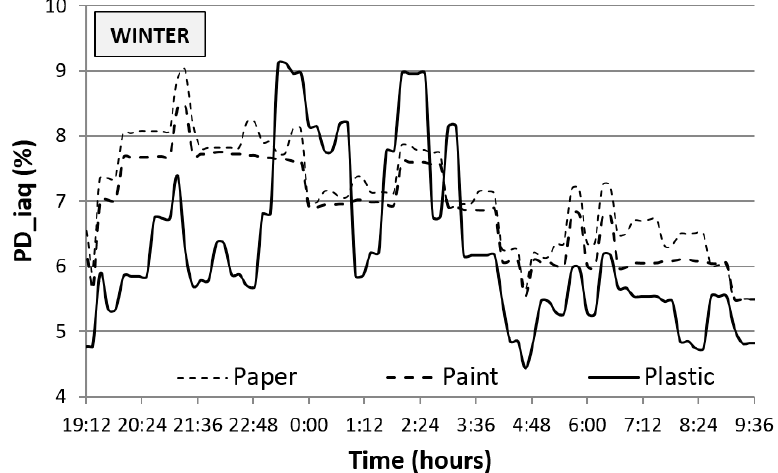
Figure 8. Indoor air enthalpy predicted for each internal covering during the winter season. Figure 9. Indoor air partial vapor pressure predicted for each internal covering during the summer season.